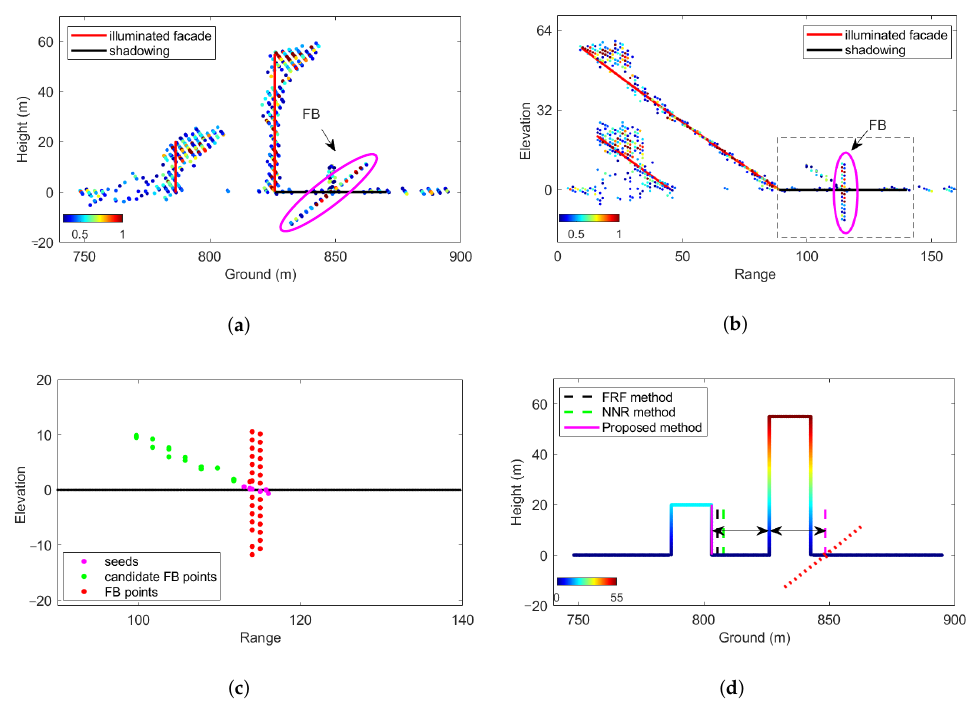
Figure 10. Illustration of the whole reconstruction process of the back of building 1 in the simulated scene 1. TomoSAR point cloud and the candidate FB scattering point detection in ( a ) the ground– height plane and ( b ) the range–elevation plane. ( c ) Detection of FB scattering points in range–elevation plane. ( d ) Reconstruction results of the back of building 1, where the line colored by height indicates the true